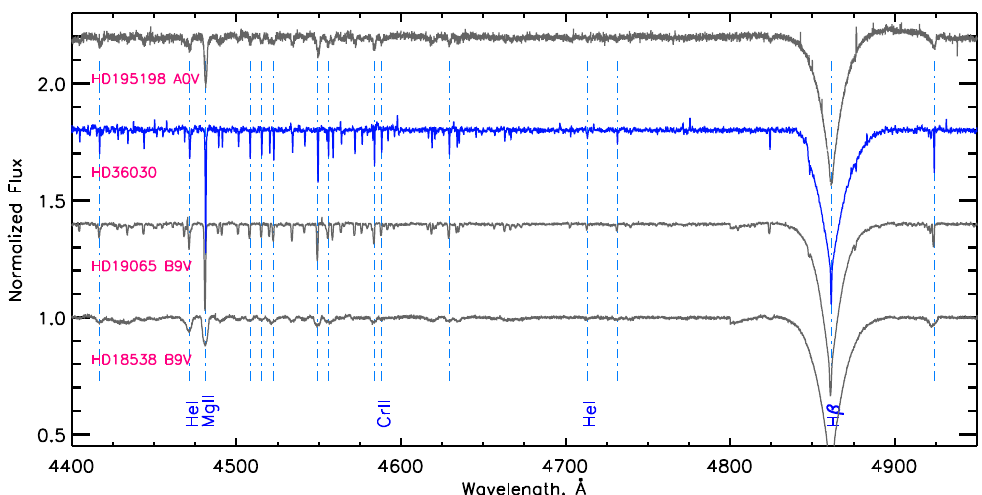
Figure 2. Comparison of HD36030 spectrum with the ones of B9 V and A0 V stars. Spectra of HD18538 and HD19065 are taken from IACOB database [36–38] (spectral resolution is R = 85,000), whereas the spectrum of HD195198 is from [39] (R = 42,000). Unnamed lines correspond to FeII. We estimated the reddening by comparing the photometric data from the Tycho-2 catalogue [40] ( B = 8.95 ± 0.02 mag and V = 8.96 ± 0.01 mag) with the intrinsic color for a B9 star 2 ( ( B − V ) 0 = − 0.07 mag; Pecaut and Mamajek [41]) as E ( B − V ) = 0.06 mag. Then, assuming the distance to its host cluster ASCC 21 to be d = 345.5 + 12.3 pc [28], the absolute − 11.6 magnitude of HD 36030 is M V = 1.09 ± 0.07 mag. It is fainter than the expected absolute